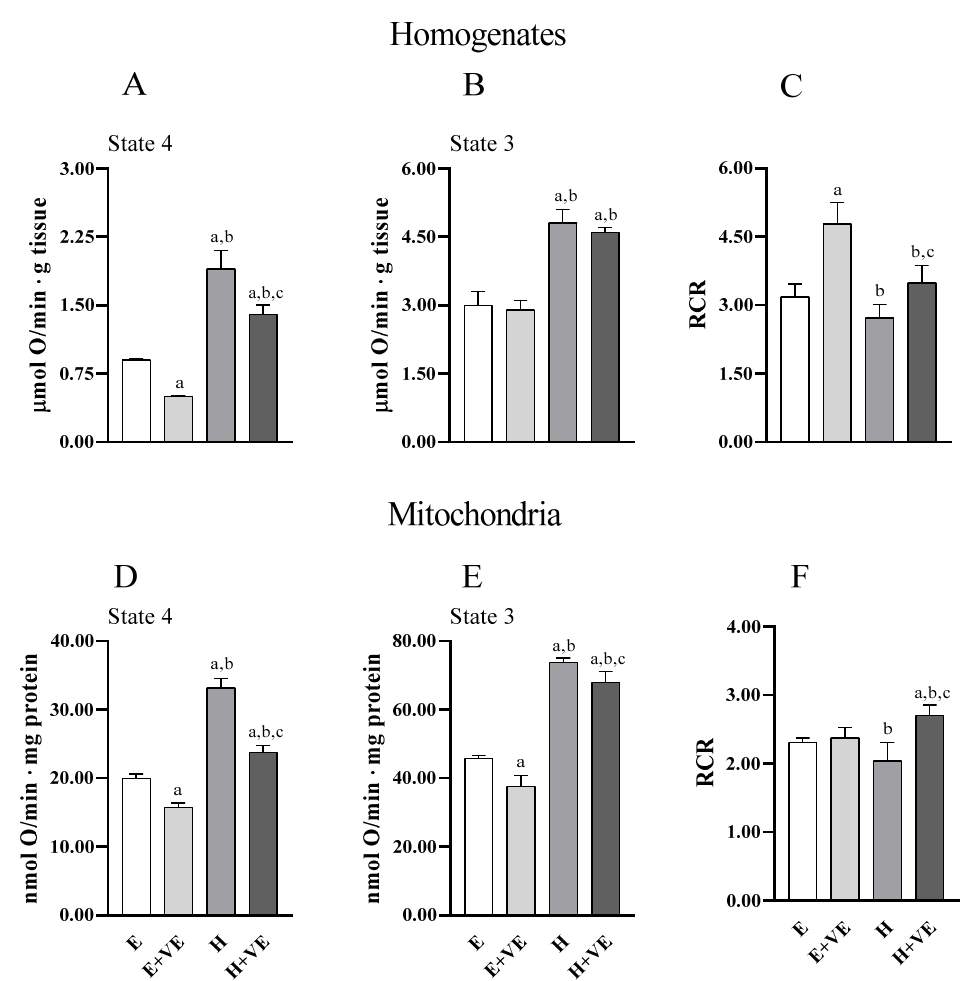
Figure 5. State 4 and State 3 oxygen consumption, and respiratory control ratio (RCR) detected in pyru- vate plus malate supplemented homogenate ( A – C ) and mitochondria ( D – F ). Values are means ± SEM of eight determinations from different mice. Each determination is the mean of three independent measures. E, euthyroid; E + VE, euthyroid fed vitamin E supplemented diet; H, hyperthyroid; H + VE, hyperthyroid fed vitamin E supplemented diet. a significant vs. E. b significant vs. E + VE. c significant vs. H. The level of significance was chosen as p <